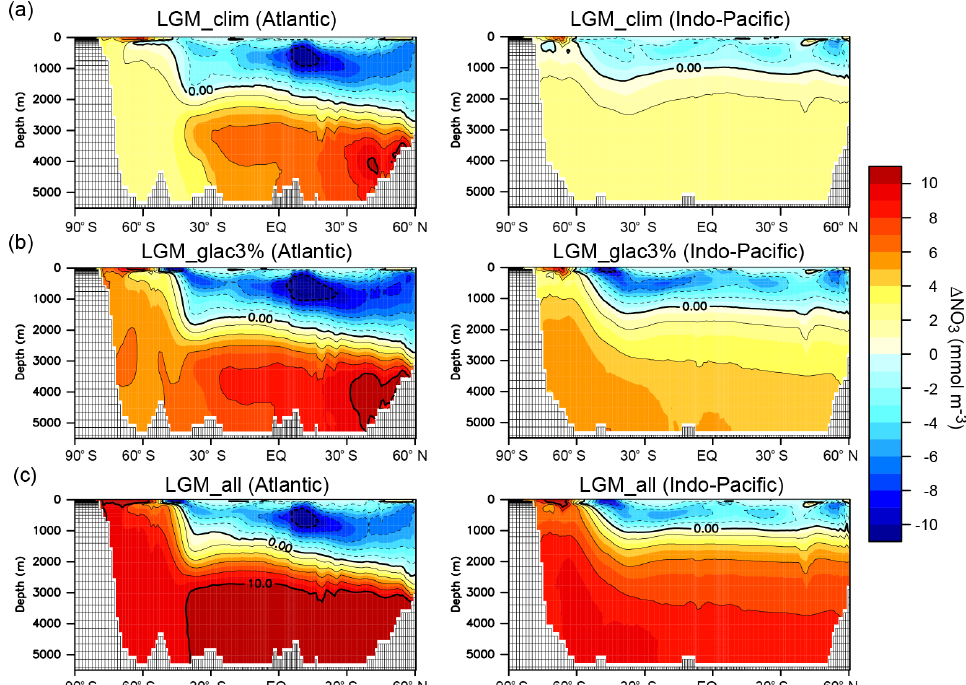
Figure 2. NO 3 change resulting from changes in the climate and biological pump in LGM simulations. Zonal mean changes in NO 3 from the PI to (a) LGM_clim, (b) LGM_glac3%, and (c) LGM_all. The left and right panels show the Atlantic and Indo-Pacific oceans,